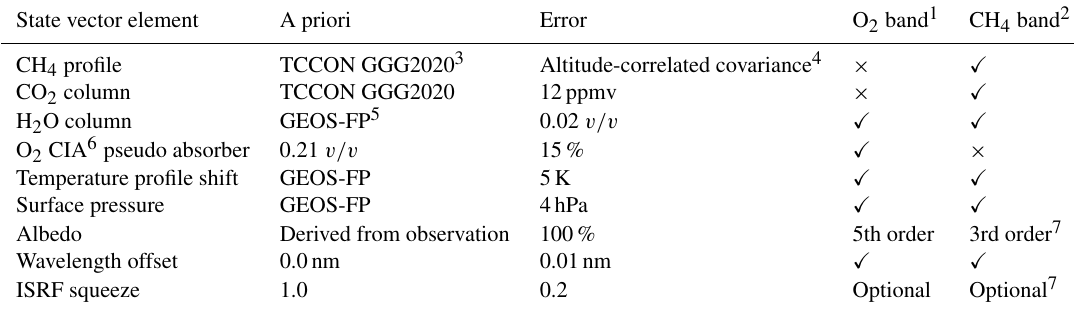
Table 2. MethaneAIR Level 2 algorithm fit settings.